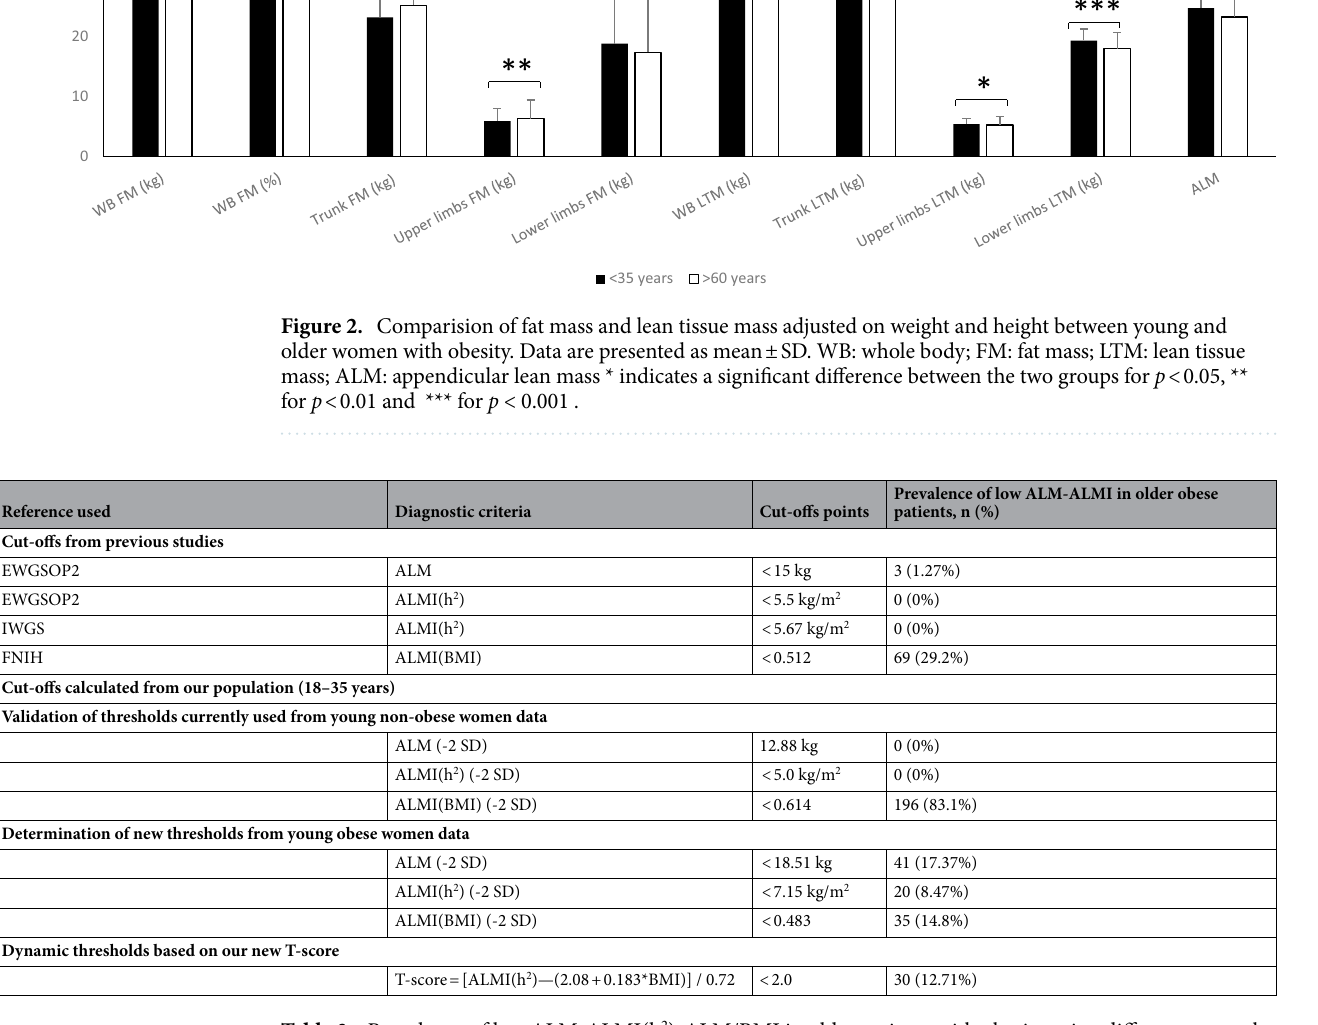
Table 3. Prevalence of low ALM-ALMI(h 2 )-ALM/BMI in older patients with obesity using different currently used and newly determined cut-offs. Data are presented as number (percentage; %) of older patients with obesity. EWGSOP2 European Working Group on Sarcopenia in Older People; IWGS the International Working Group on Sarcopenia; FNIH The Foundation for the National Institutes of Health; ALM appendicular lean mass; ALMI appendicular lean mass index [ALMI(h 2 ): ALM/height 2 and ALMI(BMI): ALM/BMI)]; BMI body mass index (weight/height 2 ). SD standard